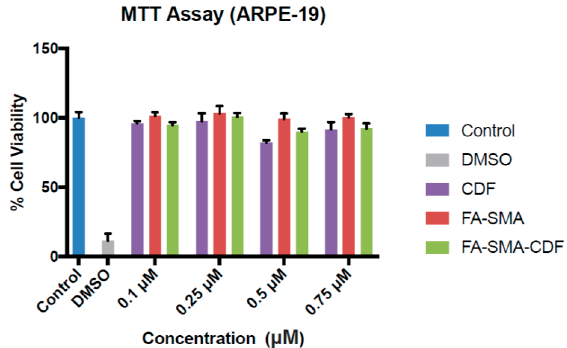
Figure 4. In vitro cell viability assay showing the percentage of cell viability observed at 24 h after treating ARPE-19 cells with the pure drug (CDF), FA-SMA and FA-SMA-CDF. Data are expressed as the percentage of control cells and the mean ± SEM.